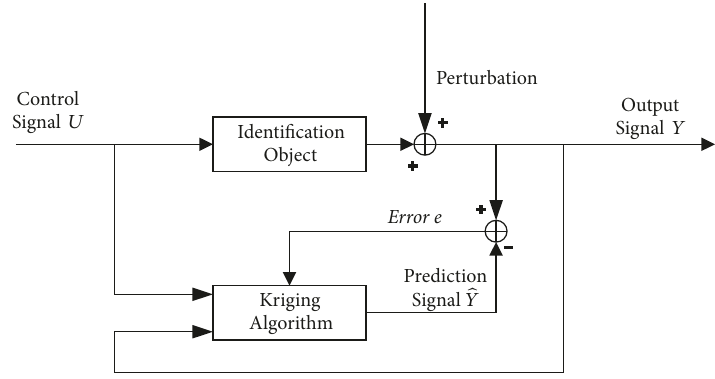
Figure 6: Inverse system